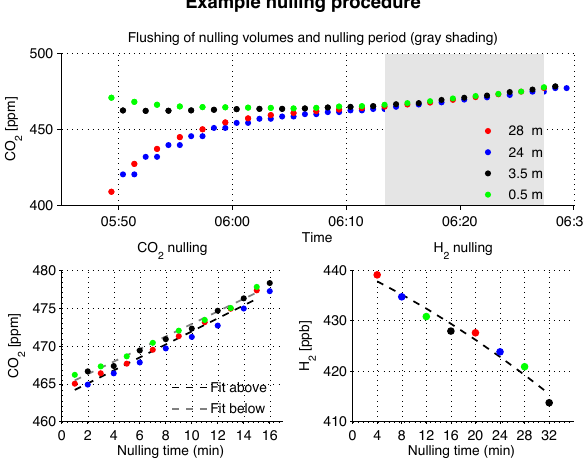
Figure 3. Two-hour period highlighting the importance of using integrating volumes for our mole fraction gradient measurements. During this period, the 0.5m inlet sample stream bypassed the in- tegrating volume ( a , blue diamonds), while the 3.5m inlet sample stream passed through the integrating volume and was physically smoothed ( a , pink points). The effect the integrating volume would have had on the 0.5m inlet measurements was simulated with an exponential moving average ( a , dark-blue points). The mole frac- tion gradients from the physically smoothed 3.5m inlet data and the 0.5m inlet measurements bypassing the integrating volume ( b , blue diamonds) were more variable than the physically smoothed 3.5m inlet data and the computationally smoothed (exponential fil- ter) 0.5m inlet data ( b , dark-blue points).